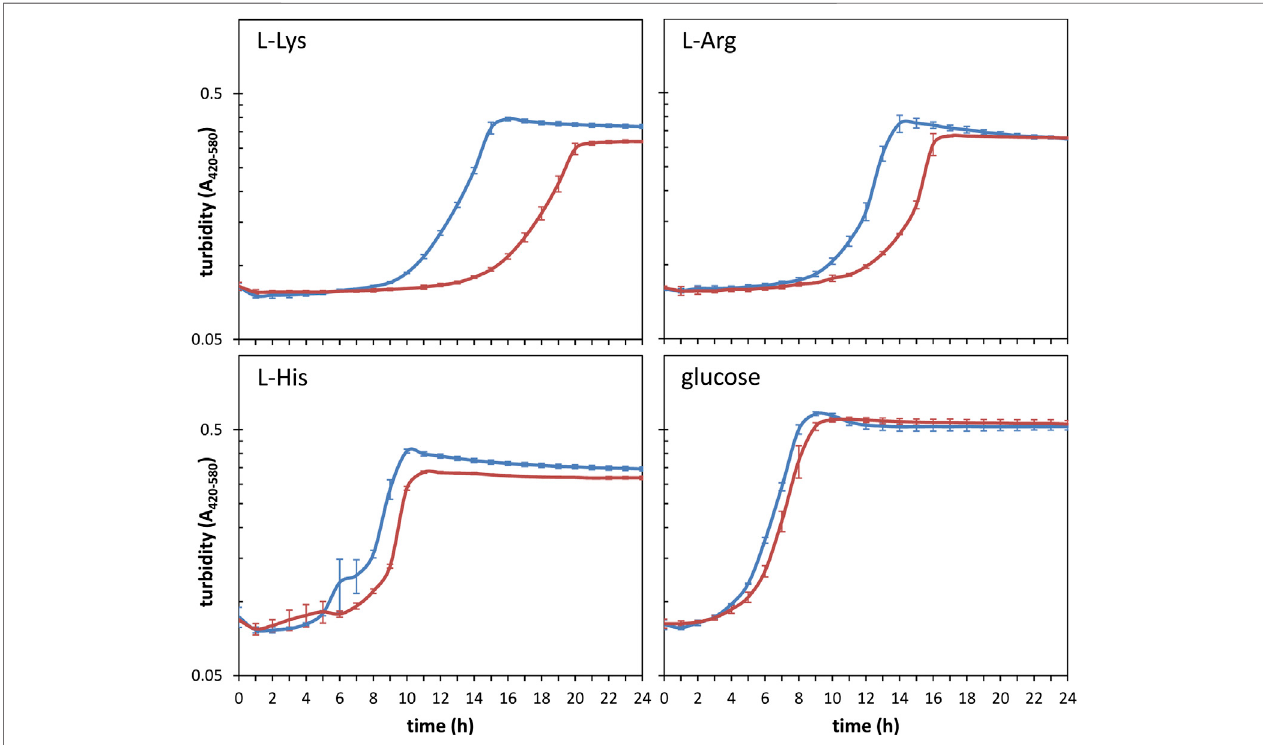
FIGURE5| GrowthofKT2440(blue)andthetriple rsm mutant(red)inM9minimalmediumwith5 mM L-lysine,L-arginine,L-histidineorglucoseascarbonsource. Culturesweregrownin96-wellplatesat30 ° CandOD 420 – 580 wasreadat1-hintervalsinanautomatedBioScreenequippedwithawideband fi lter(420 – 580 nm)tominimize potential alterations due to changes in medium color. Data are averages and standard deviations of experiments done in duplicate, with three technical replicas each.